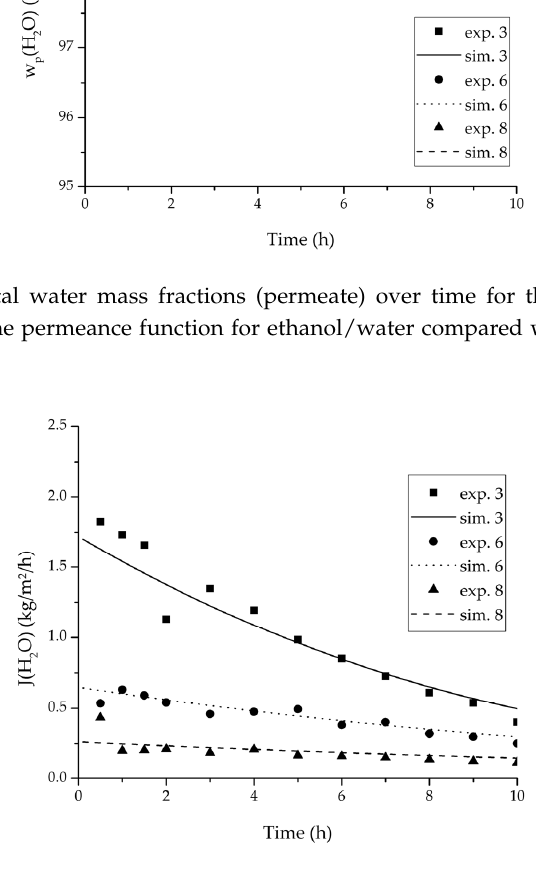
Figure 10. Experimental water flux over time for three experiments used for the validation of the permeance function for ethanol/water compared with the corresponding simulation result. Membranes 2018 , 8 , 4